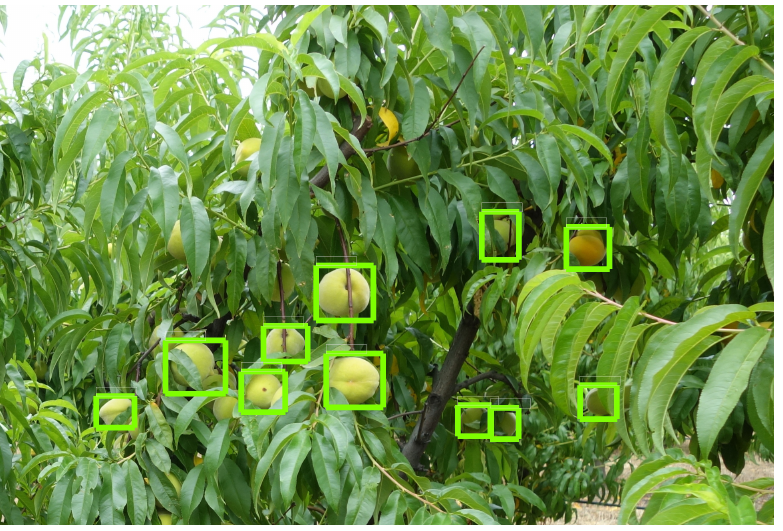
Figure 9. Example (2) of peach detection by faster R-CNN with Inception v2